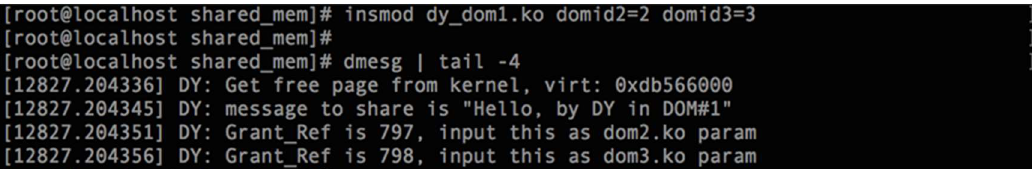
Table 6. Access matrix of VM1, VM2, and VM3.